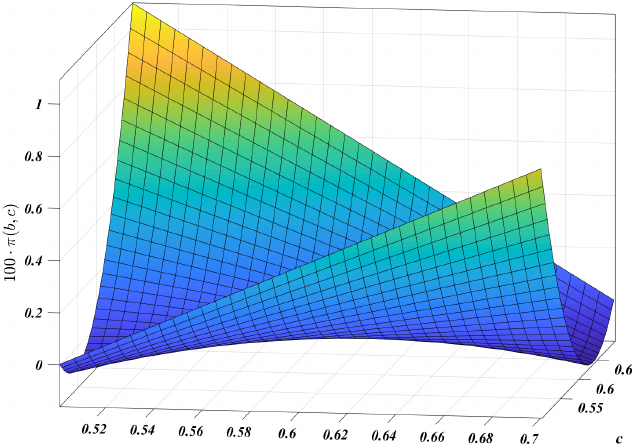
Figure 1. Payoff kernel 100 · π ( b , c ) for the parameters ν : = 0.07, σ : = 0.15, r : = 0.03, λ : = 1, x ∈